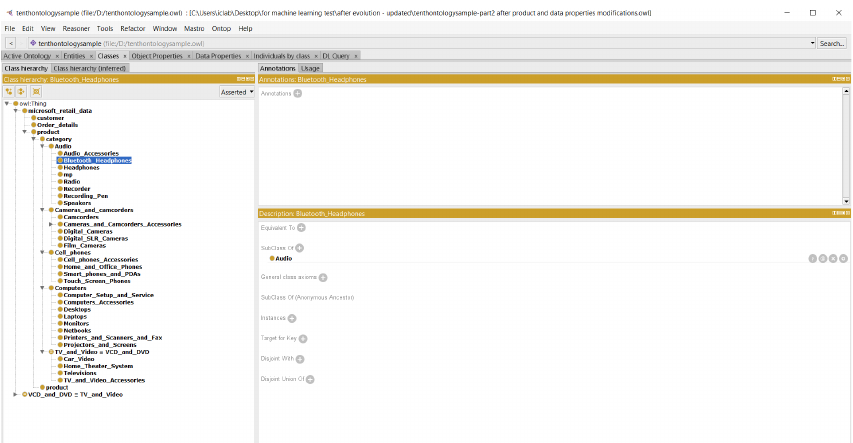
Figure 4. Online retail ontology